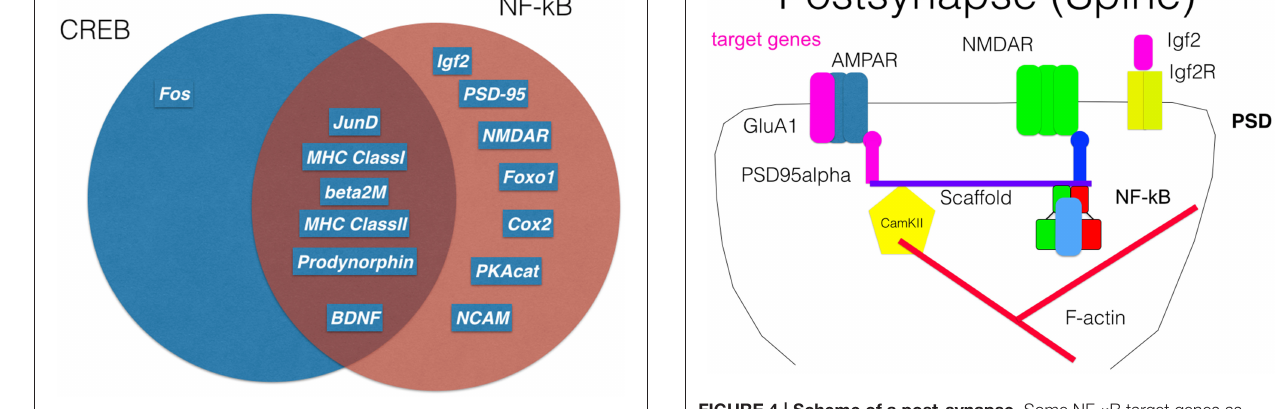
FIGURE 3 | Memory relevant target genes of NF- κ B and CREB. Genetic screens in transgenic mice identified several target genes of CREB (blue) and NF-kB(red). A Venn diagram shows overlapping target genes (dark red) of both transcription factors. For references see text.